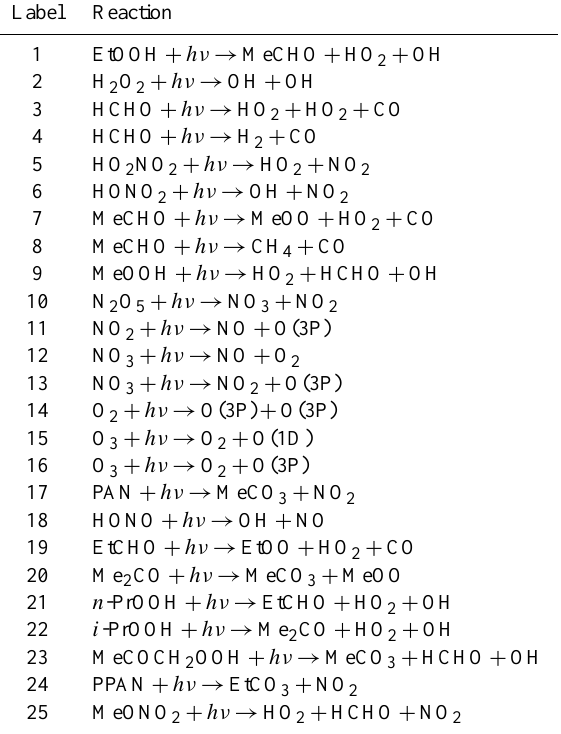
Table 4. Photolytic reactions in the UKCA standard tropospheric (StdTrop) scheme, where Me = CH 3 , Et = C 2 H 5 , Pr = C 3 H 7 , PAN = peroxy acetyl nitrate, and PPAN = peroxy propionyl